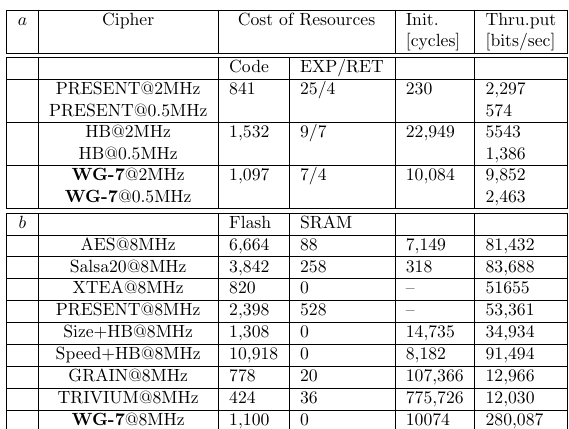
Table 8. Comparison of WG-7 and other